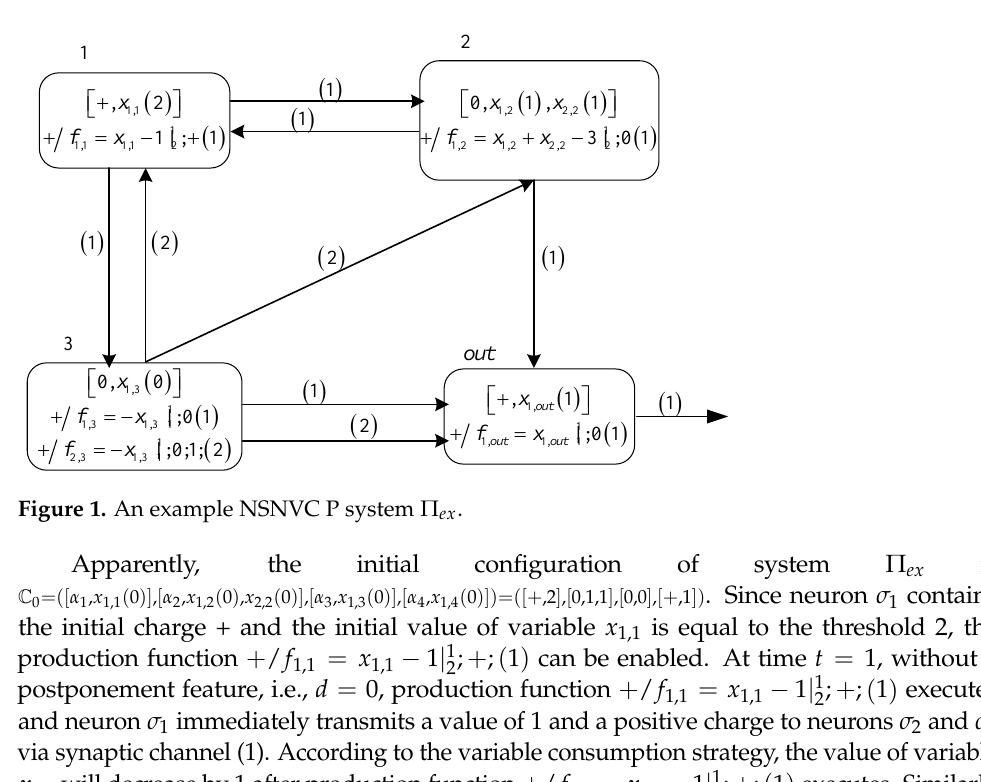
Figure 1. An example NSNVC P system Π